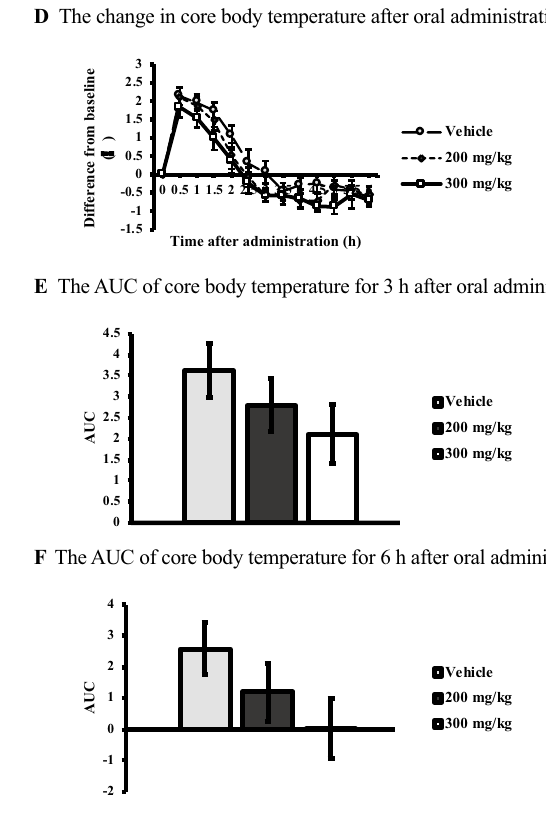
Figure 2. ( A ) Each locomotor activity amount (counts) for 6 h (ZT2–8, light period) in a new cage after oral administration of vehicle and 200 mg/kg and 300 mg/kg of sake yeast plotted with a 1 h interval. ( B ) Total locomotor activity amount (counts) for 3 h (ZT2–5, light period) in a new cage after oral administration of vehicle and 200 mg/kg and 300 mg/kg of sake yeast. ( C ) Total locomotor activity amount (counts) for 6 h (ZT2–8, light period) in a new cage after oral administration of vehicle and 200 mg/kg and 300 mg/kg of sake yeast. ( D ) The difference of core body temperature (°C) between before (baseline) and after oral administration of vehicle and 200 mg/kg and 300 mg/kg of sake yeast for 6 h (ZT2–8, light period) plotted with a 0.5 h interval. ( E ) The AUC of core body temperature for vehicle and 200 mg/kg and 300 mg/kg of sake yeast for 3 h (ZT2–5, light period). ( F ) The AUC of core body temperature for vehicle and 200 mg/kg and 300 mg/kg of sake yeast for 6 h (ZT2–8, light period). Error bars denote standard deviation of the mean. REM, rapid eye movement; NREM, non-rapid eye movement; ZT, Zeitgeber Time; AUC, area under the curve. * p-value < 0.05, ** p-value <